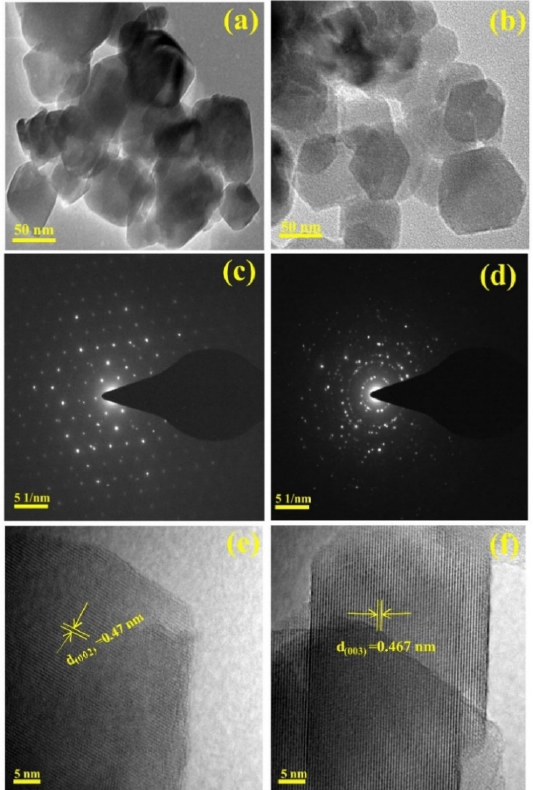
Figure 3. TEM images of ( a ) Li 2 TiO 3 , and ( b ) LiCoO 2 . SAED patterns of ( c ) Li 2 TiO 3 and ( d ) LiCoO 2 . HRTEM images of ( e ) Li 2 TiO 3 , and ( f ) LiCoO 2 .